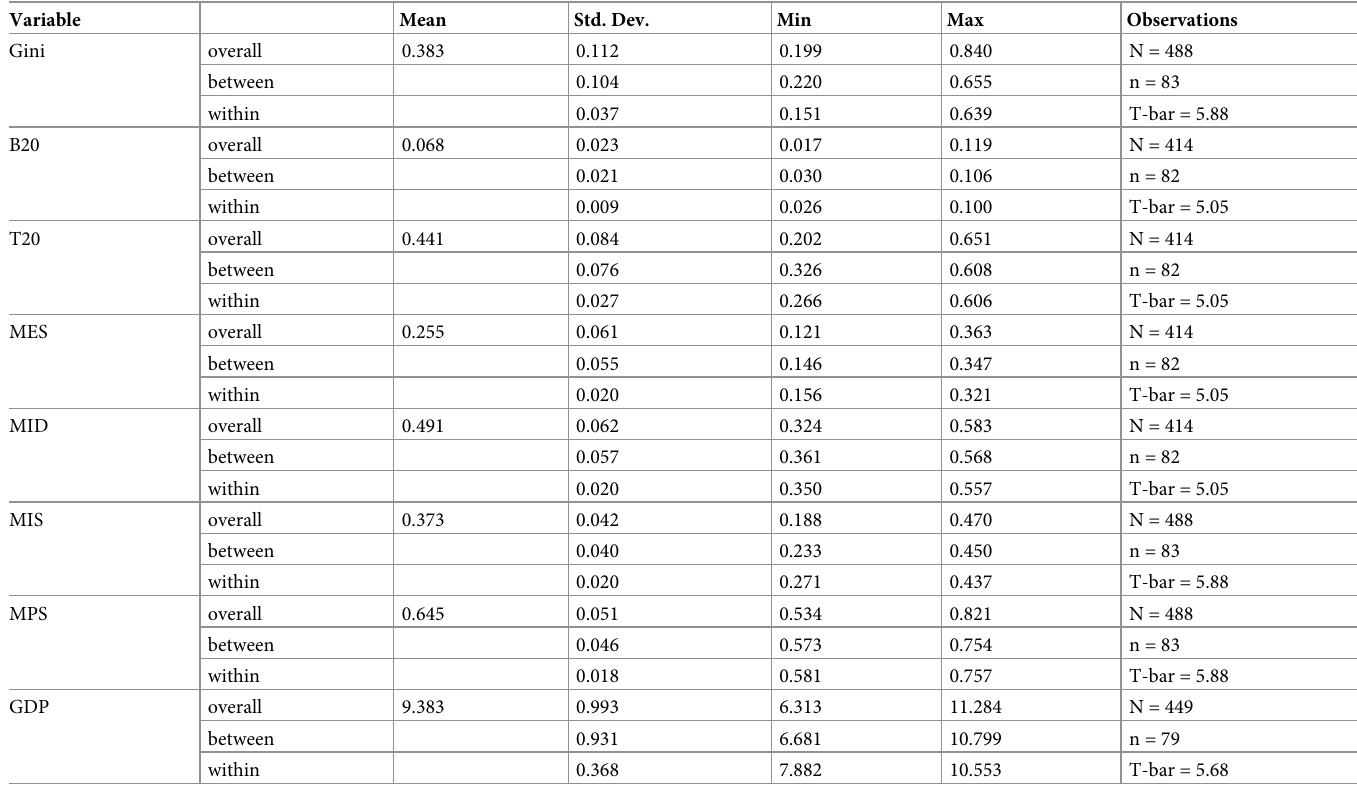
Table 1. Data summary of income inequality and GDP.